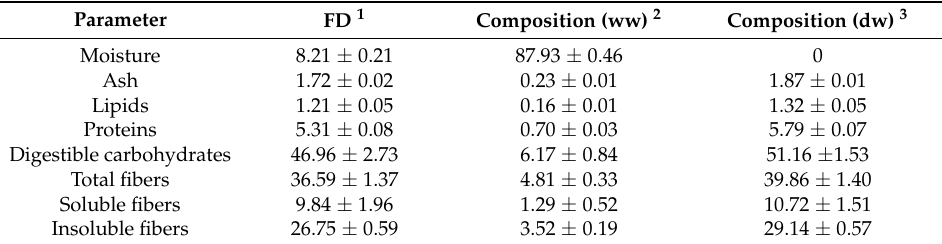
1 values expressed as percentage (%, w / w ); 2 values expressed as percentage (%, wet weight), calculated considering the moisture of FD the yield of FD, i.e., 100 g of fresh fruit result in 13.15 g of FD; 3 values expressed as